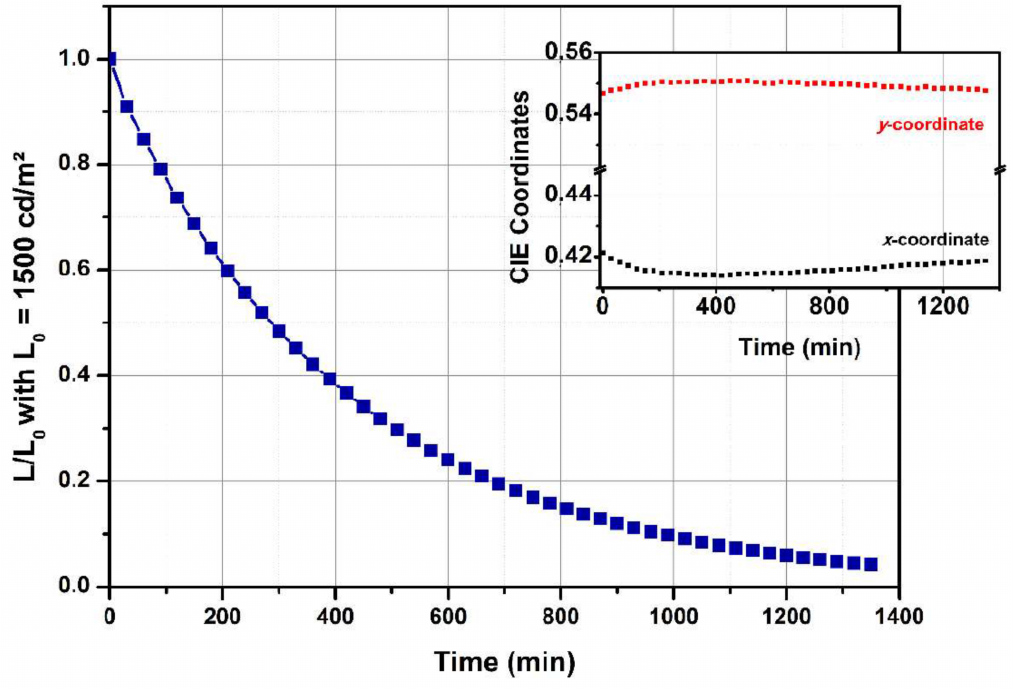
Figure 7. Time evolution of the normalized luminance, starting from an initial luminance of 1500 cd/m 2 . Inset: Evolution of CIE coordinates over